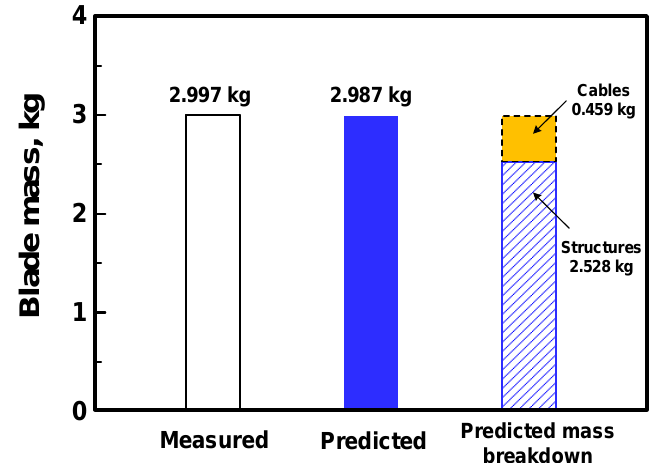
Figure 14. Validation of predicted mass against measured data.